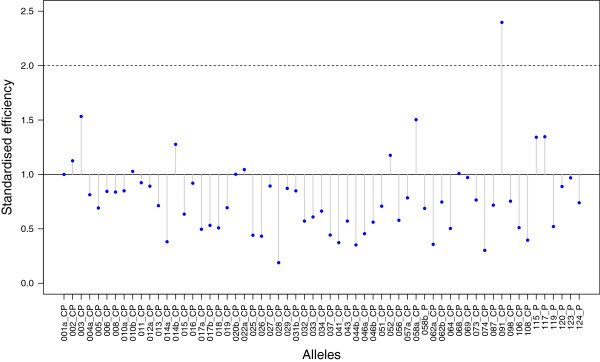
Standardised allele amplification efficiency. The amplification efficiency is estimated for each ‘putative allele’ by maximum likelihood and represented by a blue dot. Each dot is connected by a vertical line to the full horizontal line representing efficiency 1.0, which was defined using the first allele (Desu-DRB*001) as a reference (see text for details). The dashed horizontal line represents an efficiency of two, which could represent duplicated or homozygous alleles. ‘Low efficiency putative alleles’ are not represented (Desu-DRB*009a, Desu-DRB*053b, Desu-DRB*053c).